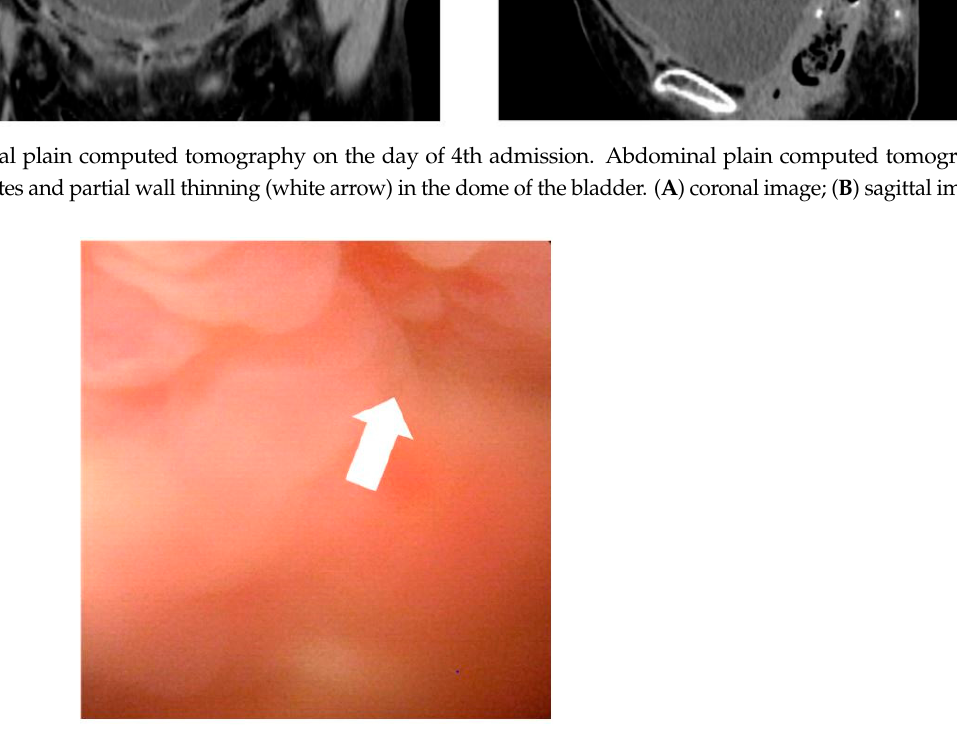
Figure 3. Cystoscopy on the day of 4th admission. Cystoscopy showed no tumor or fistula, but showed granular edematous mucosa in the same part of wall thinning on computed tomography at 4th admission (white arrow).